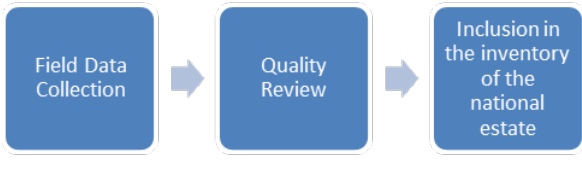
Figure 2: Basic data flow